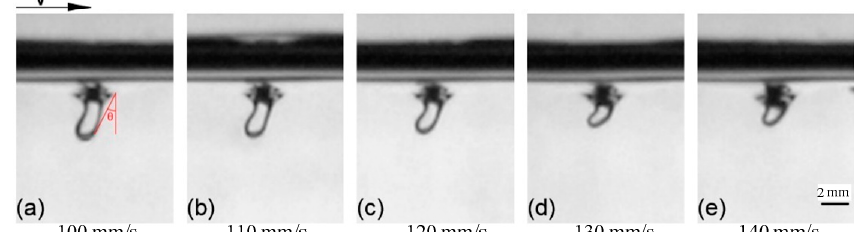
Figure 6. Keyhole during horizontal movement of nozzle: ( a ) Keyhole with nozzle moving speed of 100 m/s; ( b ) Keyhole with nozzle moving speed of 110 m/s; ( c ) Keyhole with nozzle moving speed of 120 m/s; ( d ) Keyhole with nozzle moving speed of 130 m/s; ( e ) Keyhole with nozzle moving speed of 140 m/s.